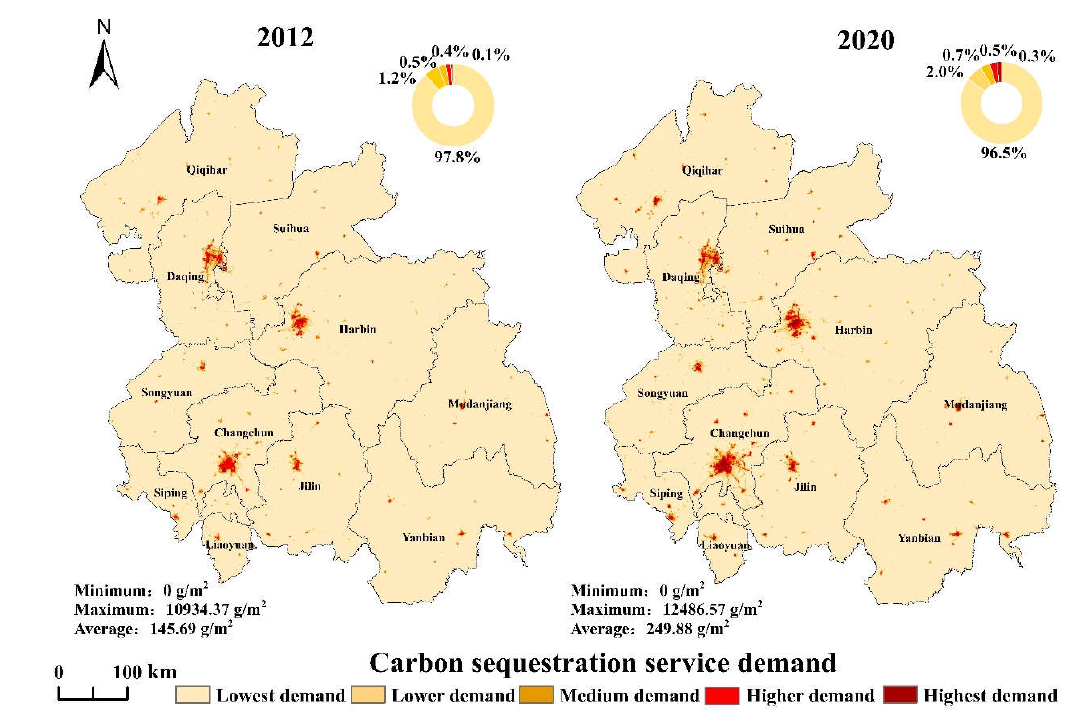
Figure 4. The spatial and temporal patterns of carbon sequestration service demand.